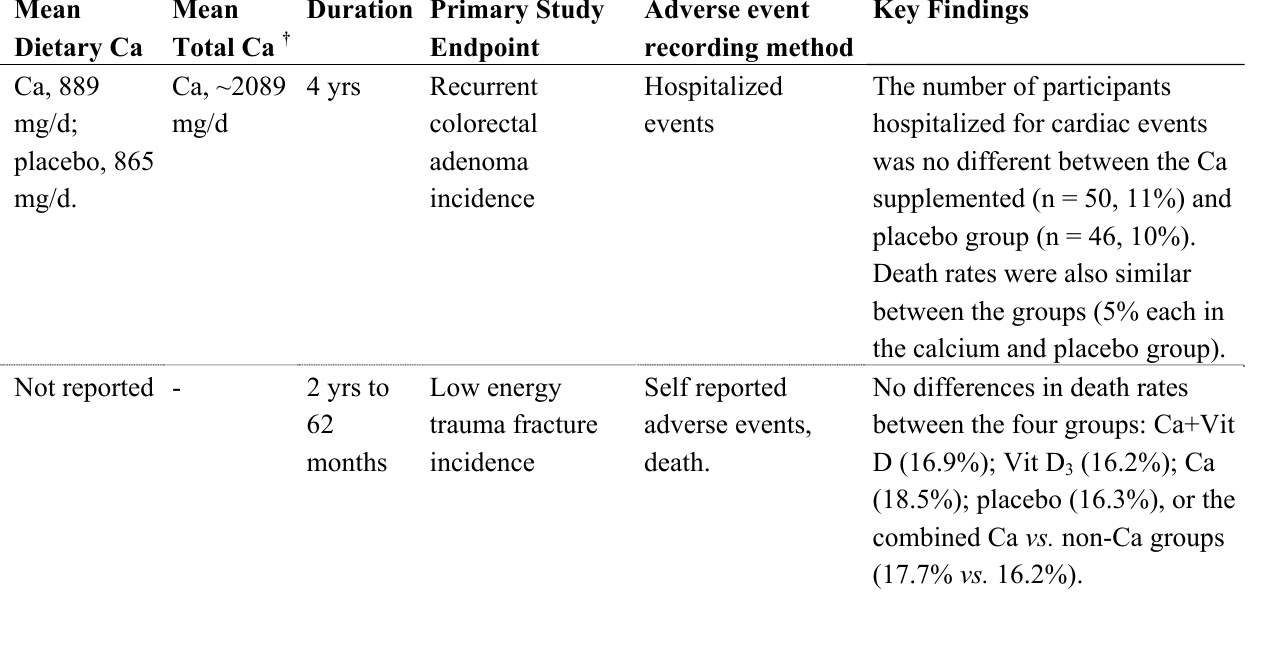
Table 1. Summary of the results from randomised controlled trials that evaluated the effects of calcium supplementation or combined calcium-vitamin D supplementation on cardiovascular related